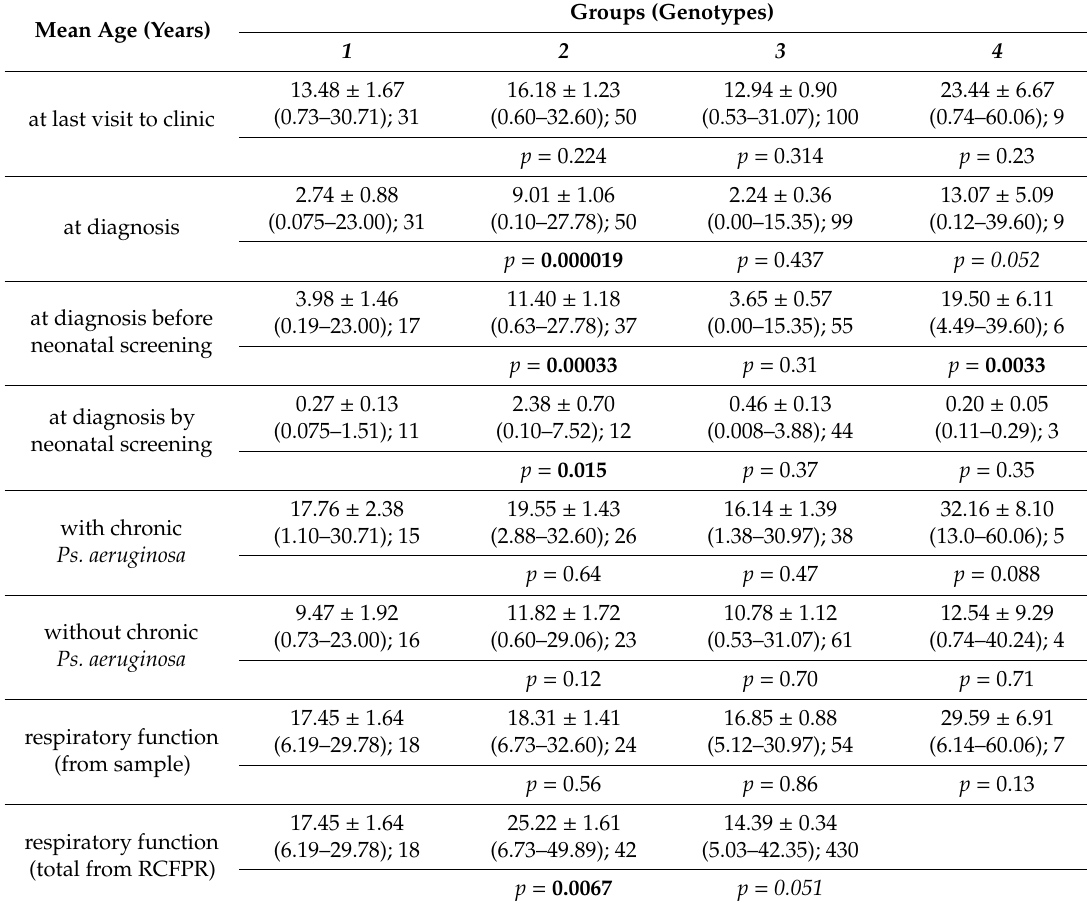
Table 2. Mean age of clinical functional manifestation of CF in patients with various